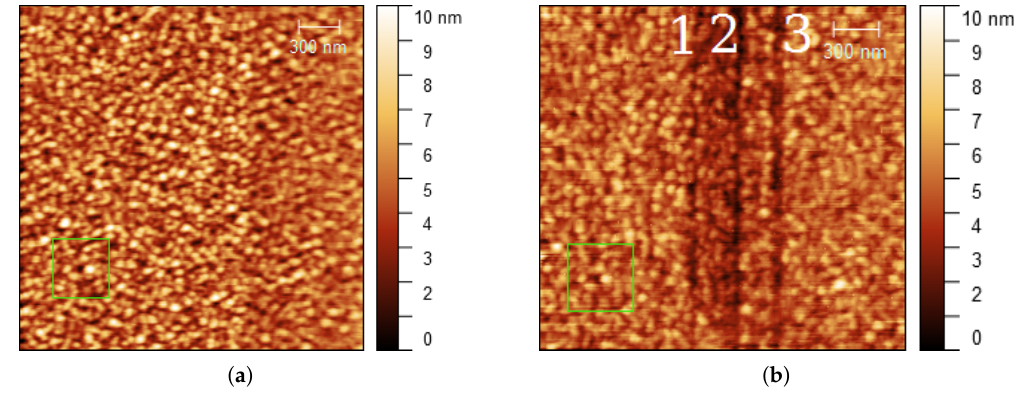
Figure 4. Nanolithography dependence on the number of scans at tip illumination. Gold on glass (30 nm thickness) ( a ) before laser irradiation and ( b ) after laser irradiation at three lines (slow axis scanning from left to right stopped). Number of scans: 7 (line 1), 10 (line 2) and 14 (line 3), scanning speed 0.62 µ m/s, angle of incidence θ = 88 ◦ , I = 2.4 × 10 8 W/cm 2